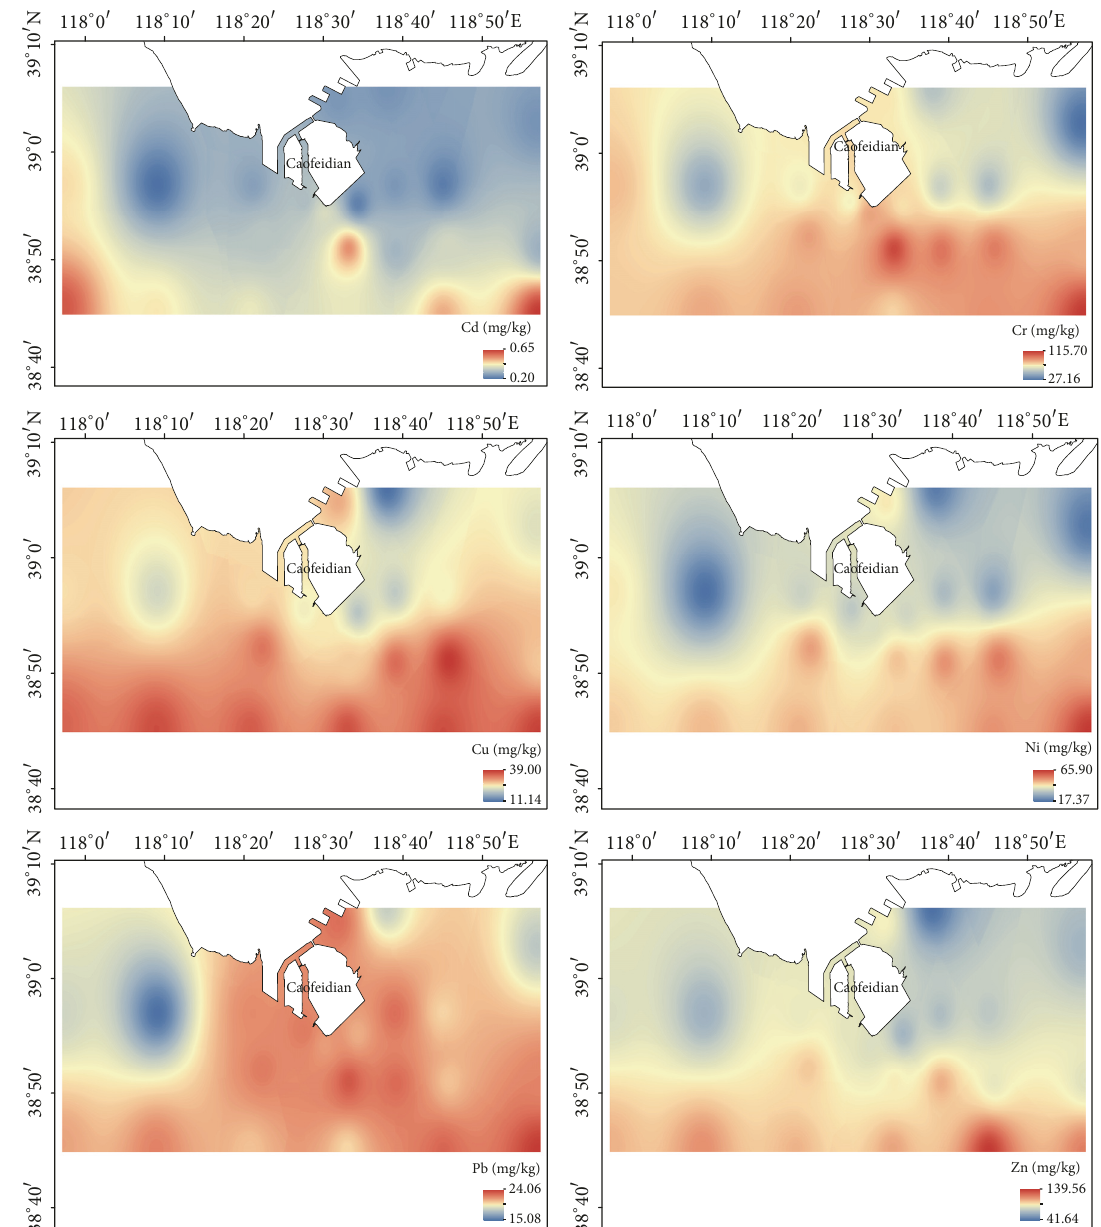
Figure 3: The spatial distribution of heavy metals in the